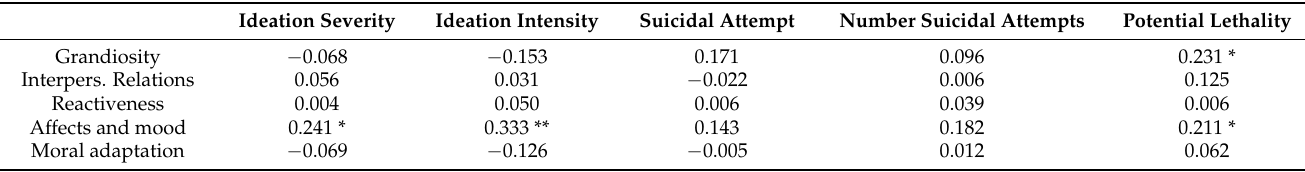
Table 2. Correlational analysis grandiosity, interpersonal relations, reactiveness, affects and mood, moral adaptation, with CSSRS suicidality